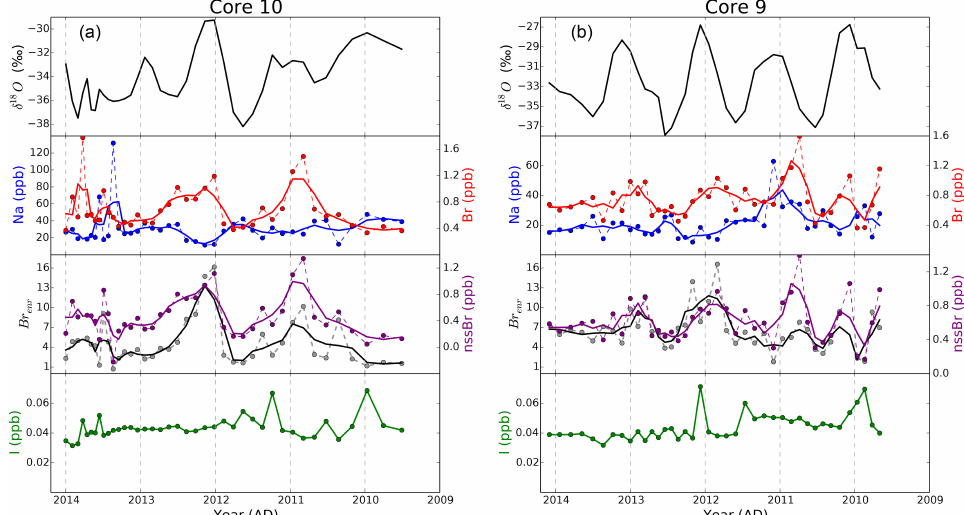
Figure 4. Variability of δ 18 O (upper panel), Na (middle top panel, left axis), Br (middle top panel, right axis), Brenr (middle bottom panel, left axis), nssBr (middle bottom panel, right axis) and I (bottom panel) in cores 10 (left) and 9 (right). Thick lines represent 3-month running means of the raw data (circles).